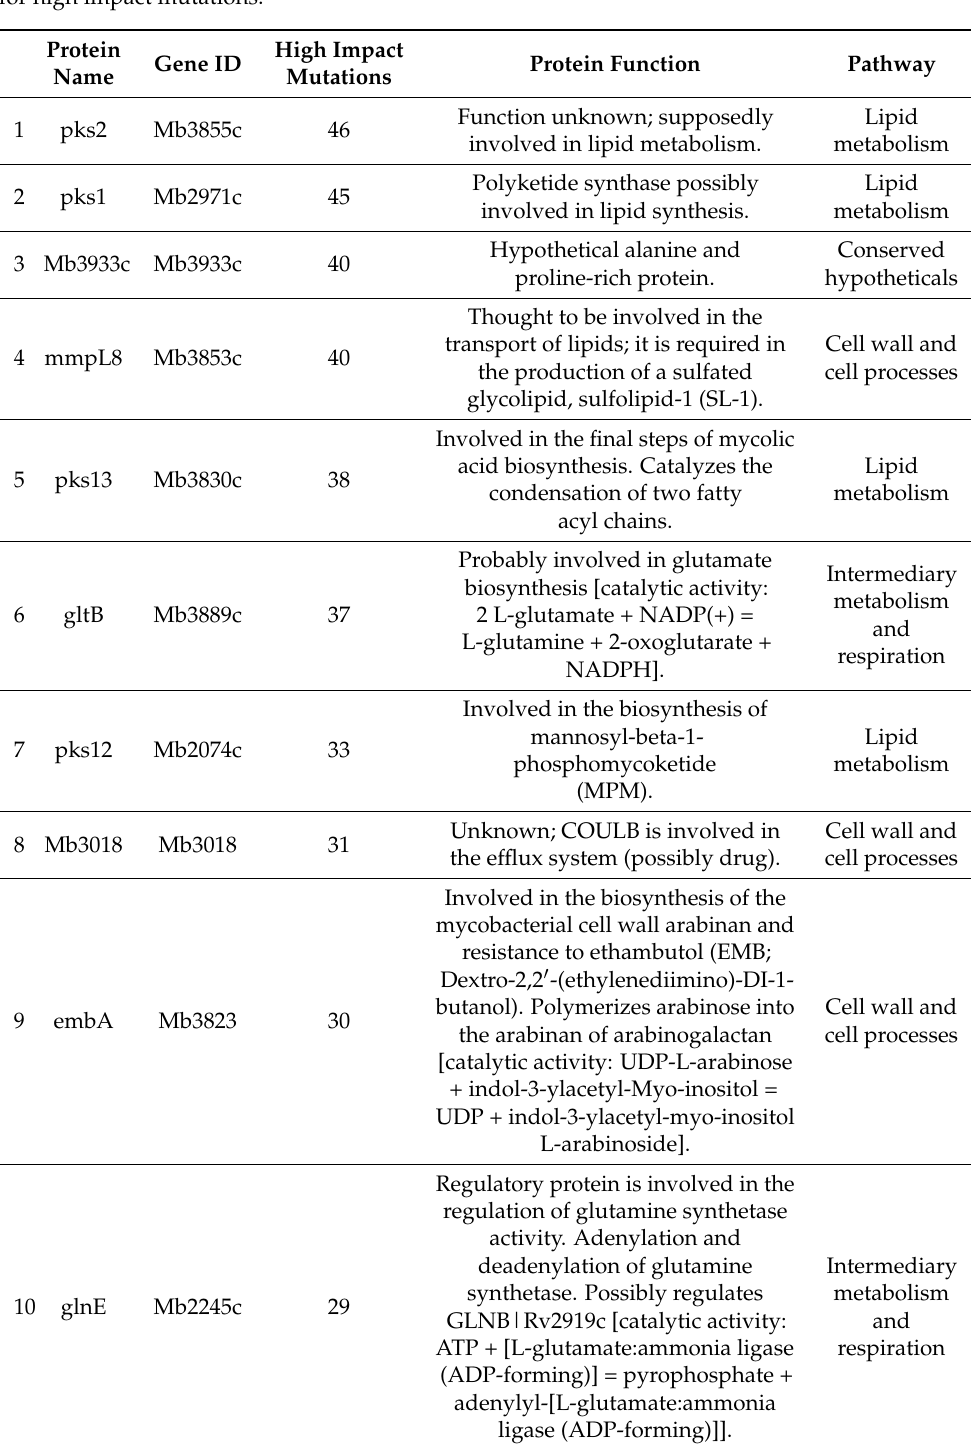
Table 2. List of top 10 proteins with the highest number of mutations in each of the proteins accounting for high impact